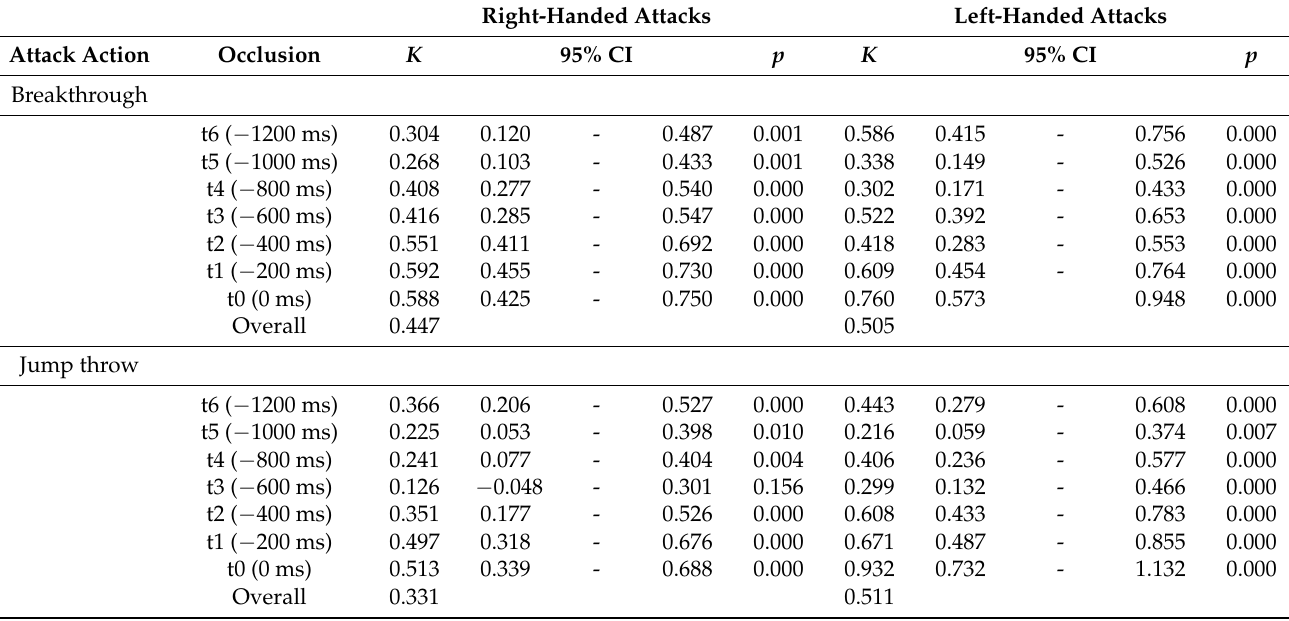
Table 2. Inter-session agreement of the CoMR in all right and left-handed attacks. Agreement of four responses from 2 video pairs (one pair in each of both sessions) for each occlusion of an attack was assessed using Fleiss’s kappa ( K ). The 95% confidence interval (CI) and significance values ( p ) were